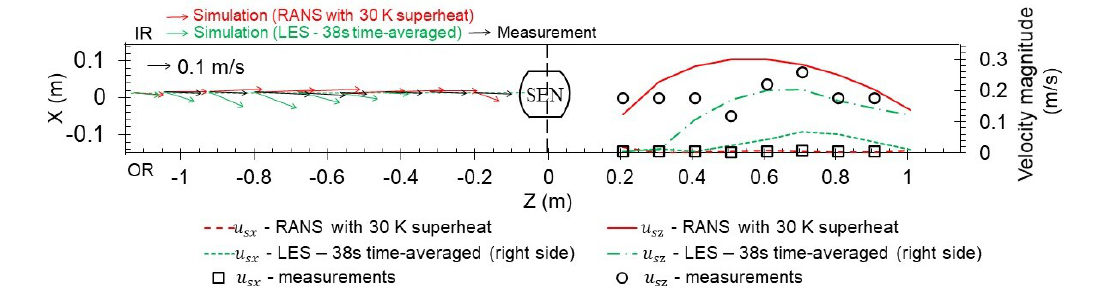
Figure 9. Flow model verification and validation.